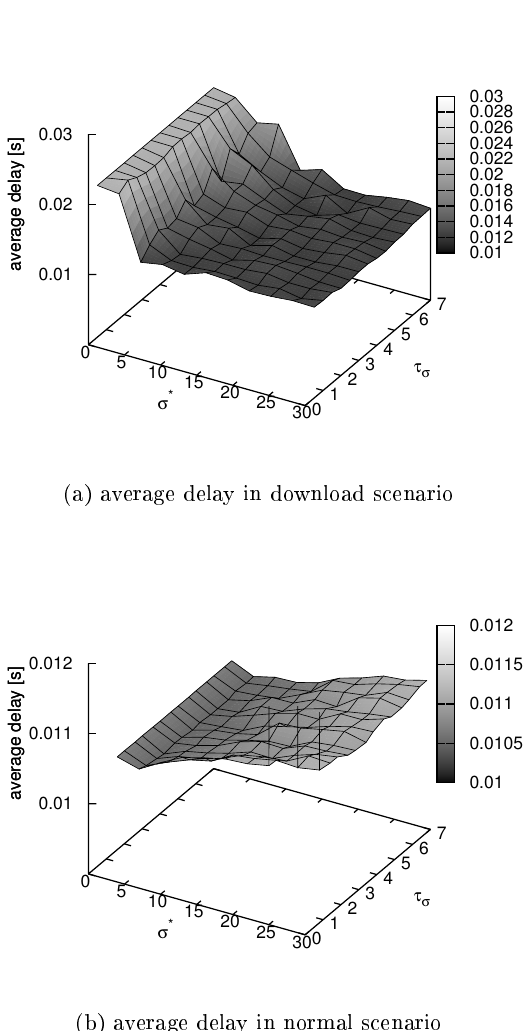
tion;the download scenario and a stationary scenario where packet generation rate is (cid:28)xed to 10Kbps for all source- destination pairs. For large maximum noise strength σ